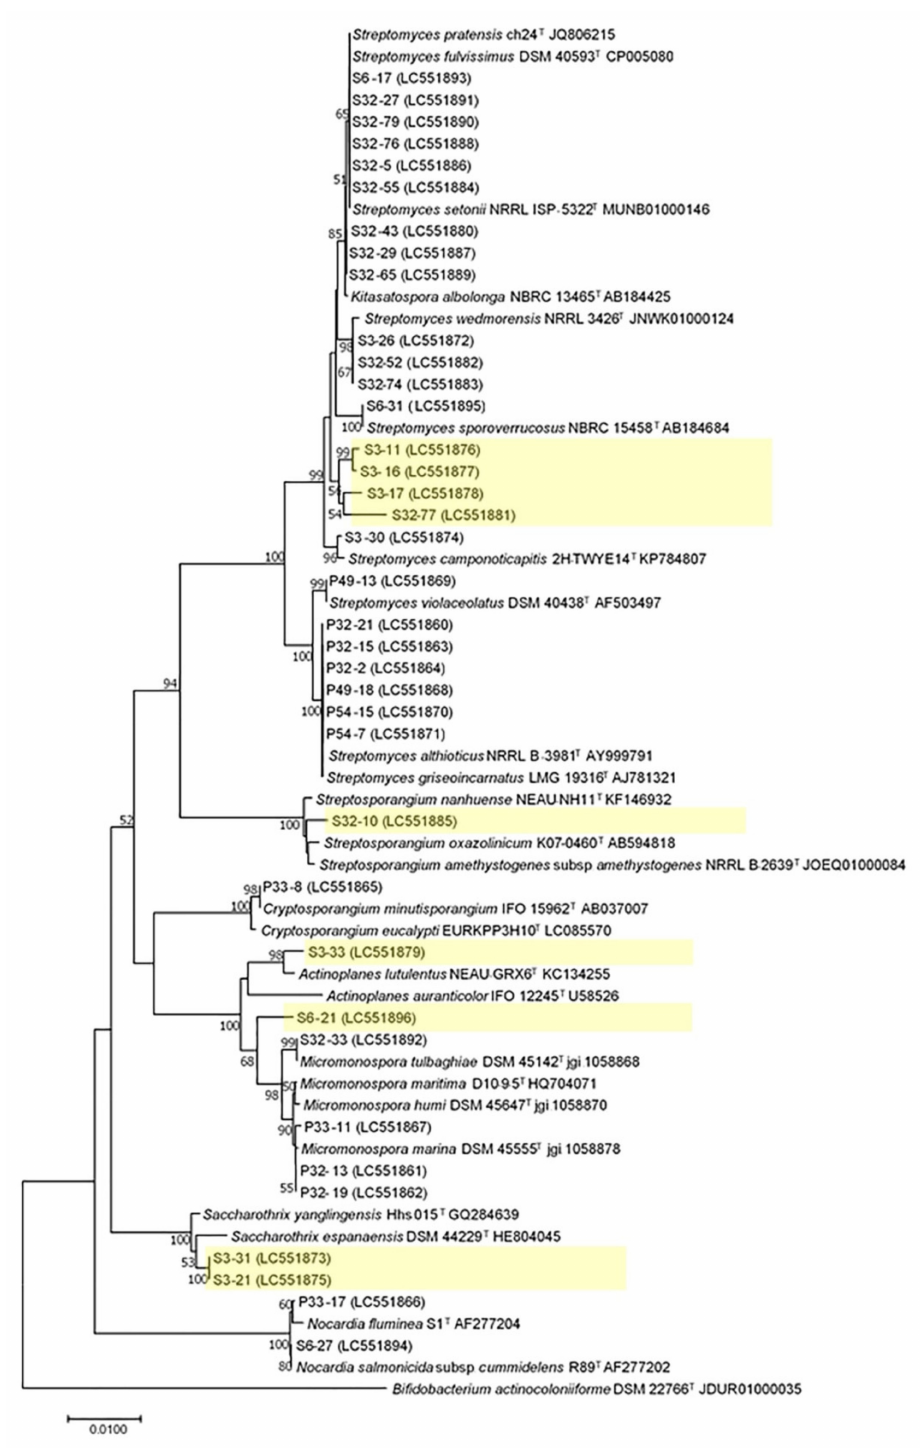
Figure 6. Phylogenetic tree of actinobacteria from mosses. The tree was inferred using the Neighbor- Joining method [29]. The percentage of replicate trees in which the associated taxa clustered together in the bootstrap test (1000 replicates) are shown next to the branches. The values less than 50 were removed. The evolutionary distances were computed using the Maximum Composite Likelihood method [30]. Evolutionary analyses were conducted in MEGA7. The five highlighted clades in yellow likely belong to seven new